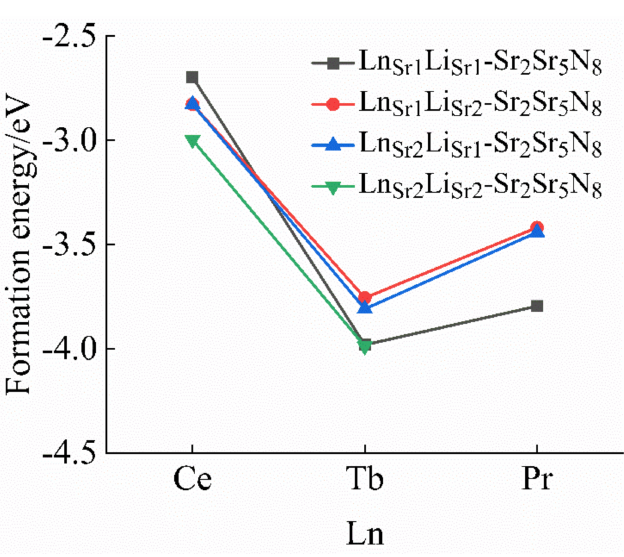
Figure 6. Formation energies of Ln 3+ /Li + elements co-doped Sr 2 Si 5 N 8